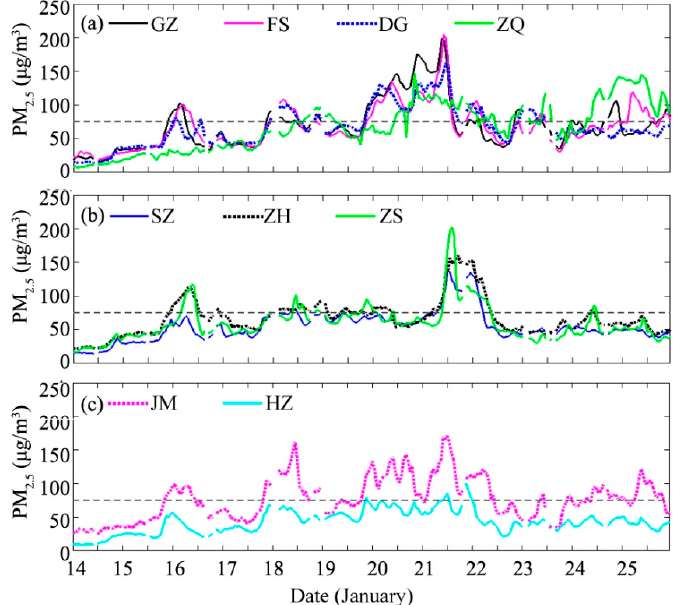
Figure 3. Hourly concentration of fine particulate matter (PM 2.5 ) in some cities in the PRD from 14 to 25 January 2015. ( a ) Guangzhou (GZ), Foshan (FS), Dongguan (DG), and Zhaoqing (ZQ); ( b ) Shenzhen (SZ), Zhuhai (ZH), and Zhongshan (ZS); ( c ) Jiangmen (JM) and Huizhou (HZ).